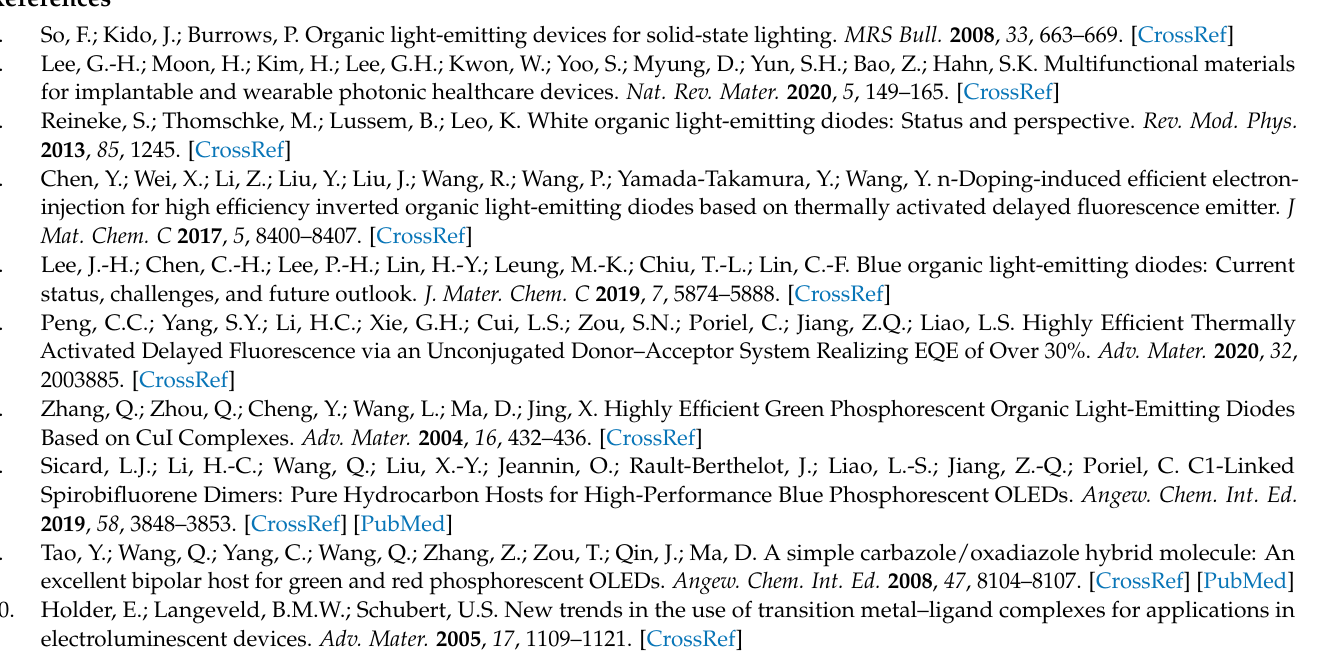
H1. Heating rate: 10 ◦ C/min, Figure SI 2: TGA curve of compound H2. Heating rate: 10 ◦ C/min, Figure SI 3: Photoluminescence and phosphorescence spectra of THF solutions of the materials H1 and